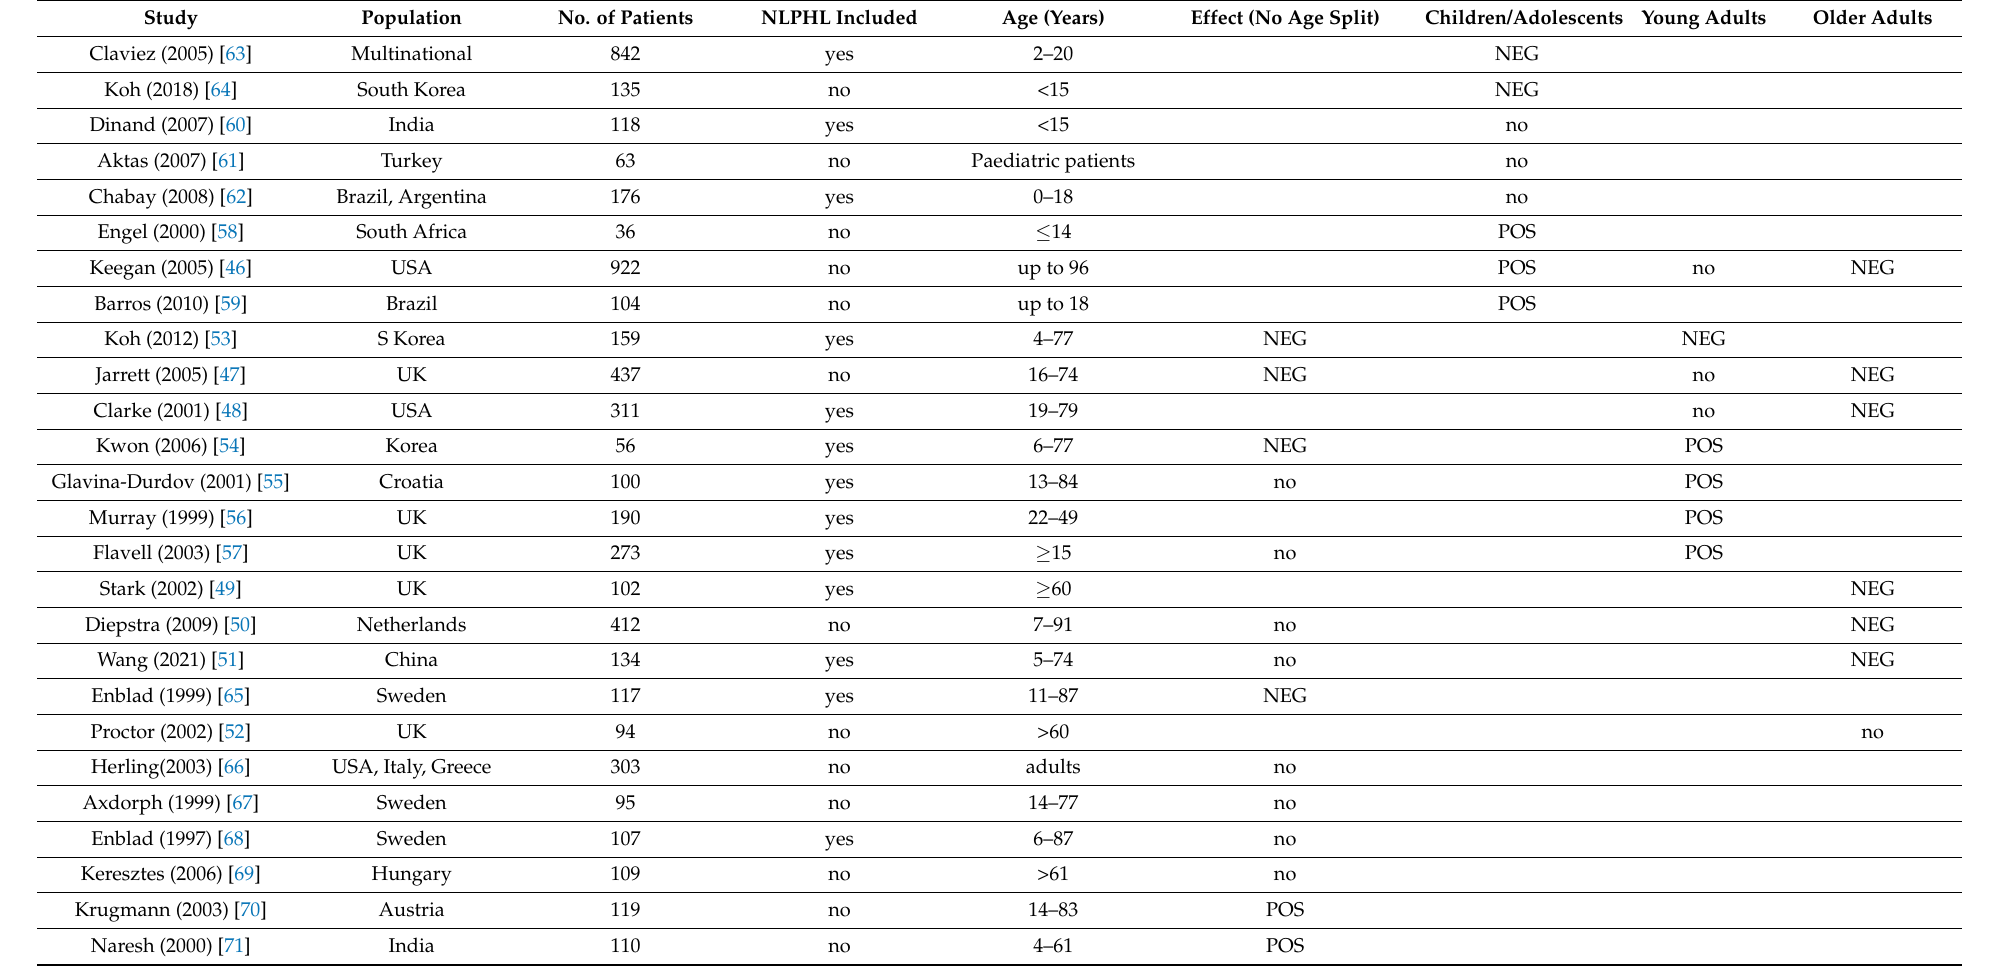
Table 1. Summary of the impact of EBV on clinical outcome from published literature. Nodular lymphocyte-predominant Hodgkin lymphoma (NLPHL) cases were included in some studies. POS: positive effect of EBV on clinical outcome; NEG: negative effect of EBV on clinical outcome. “no” means no significant effect of EBV on clinical outcome. “No entry” means that the effect on clinical outcome was not studied in that group. * This was a meta-analysis that did not take age into